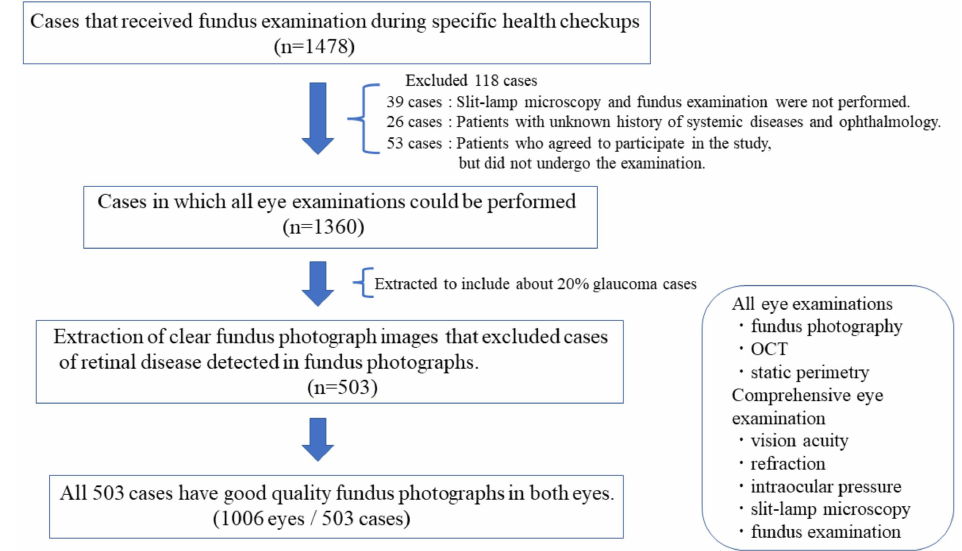
Figure 2. Criteria for extracting 503